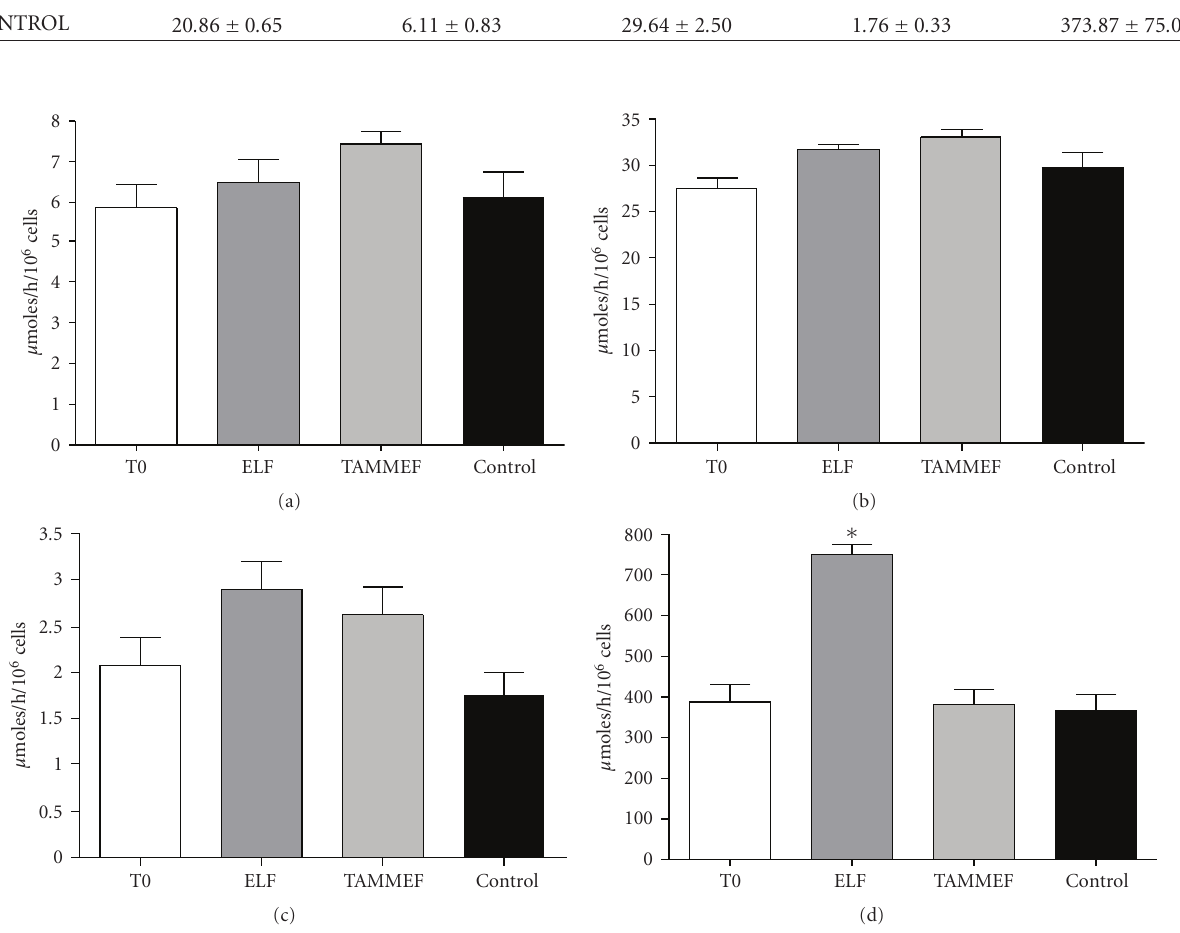
Figure 4: Enzymatic activity ( μ mol/h/10 6 PMBCs; mean ± SD of five independent experiments) of ECTO-5 (cid:2) -NT (a), ADA (b), AdK (c), and AK (d) in T0 cells, control cells, and cells treated with ELF EMFs and TAMMEFs, ∗ P < . 05 compared with T0 and with